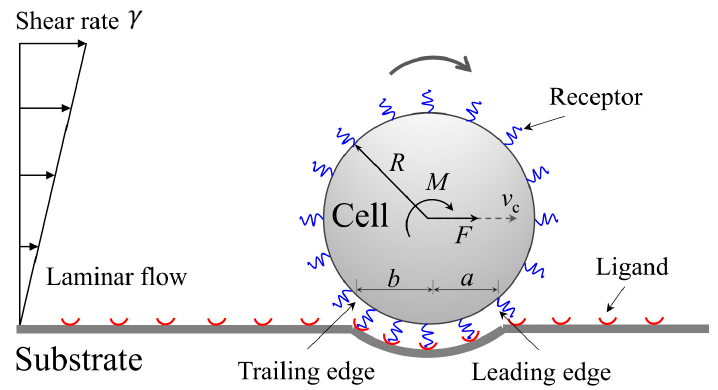
Figure 1. Schematic of rolling adhesion of cell to substrate under shear flow.